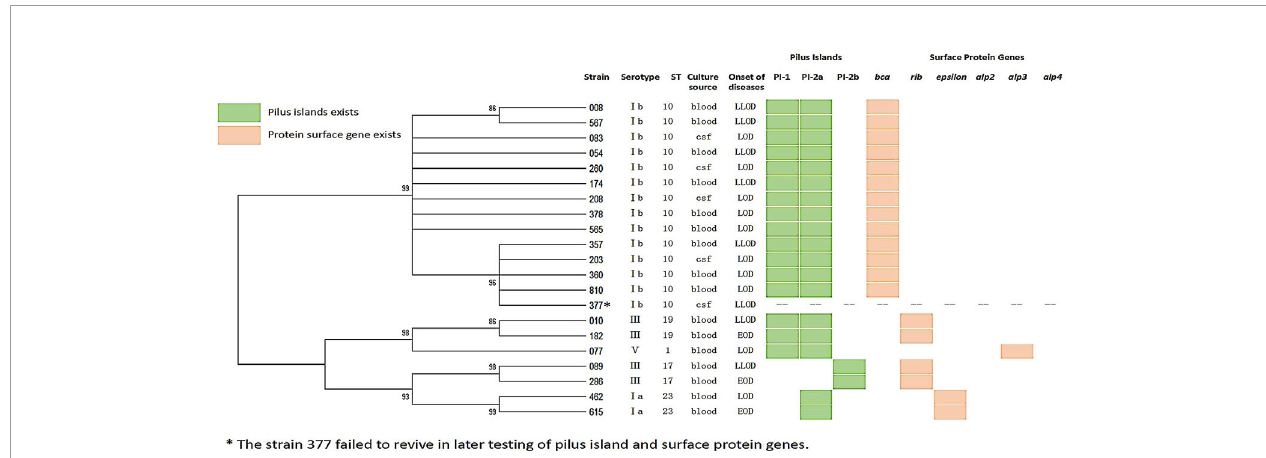
FIGURE 1 | Dendrogram constructed from the multi-locus sequence typing (MLST) pro fi les of seven housekeeping genes of 21 GBS isolates.